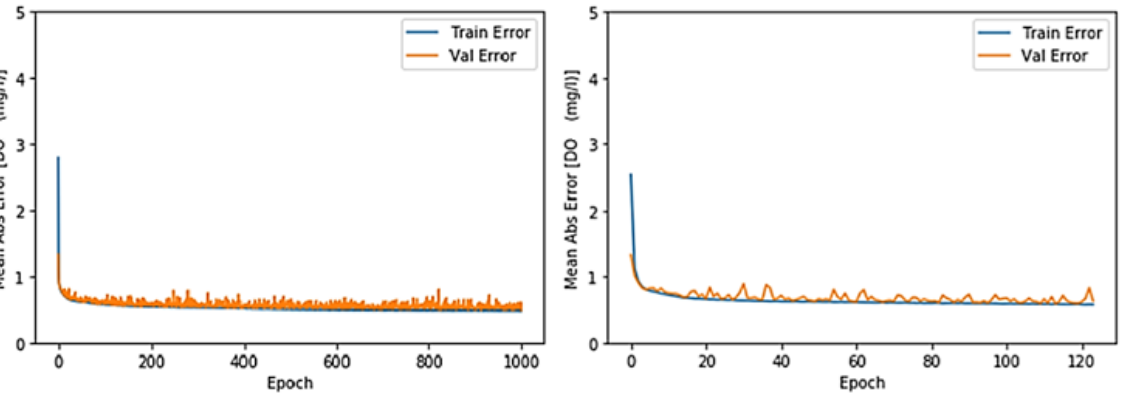
Figure 12. Mean absolute error (Toichio station, structure 4-32-32-1).